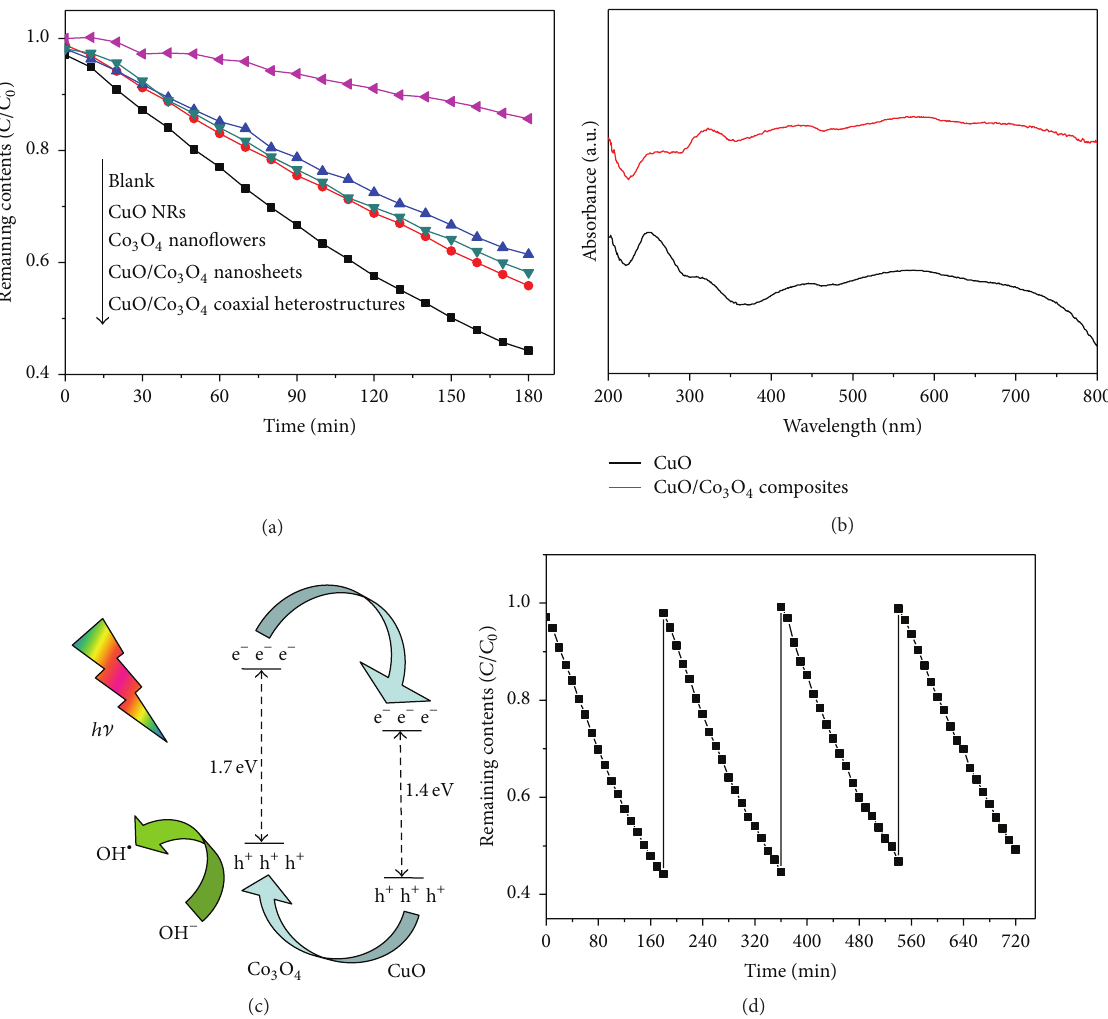
Figure 7: (a) Comparison of photocatalytic activities of bare CuO NRs and CuO/Co 3 O 4 composites for the photocatalytic decolorization of MB in water. (b) UV-Vis absorption spectra of CuO NRs and CuO/Co 3 O 4 coaxial heterostructures. (c) Proposed charge separation for CuO/Co 3 O 4 coaxial heterostructures under light irradiation. (d) Cycling degradation curves for CuO/Co 3 O 4 coaxial